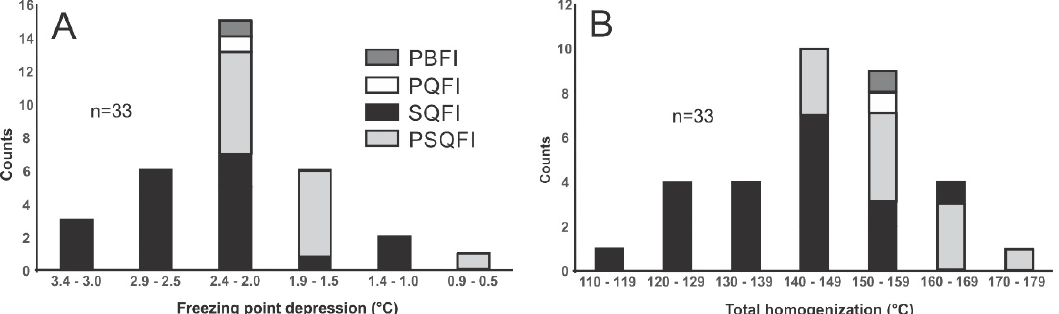
Figure 6. Histograms of the freezing point depression ( A ) and total homogenization ( B ) temperatures for the primary, secondary, and pseudosecondary two-phase (liquid + vapor) fluid inclusions (Table 2). PBFI = primary barite-hosted fluid inclusion, PQFI = primary quartz-hosted fluid inclusion, SQFI = secondary quartz-hosted fluid inclusion, PSQFI = pseudosecondary quartz-hosted fluid inclusion.